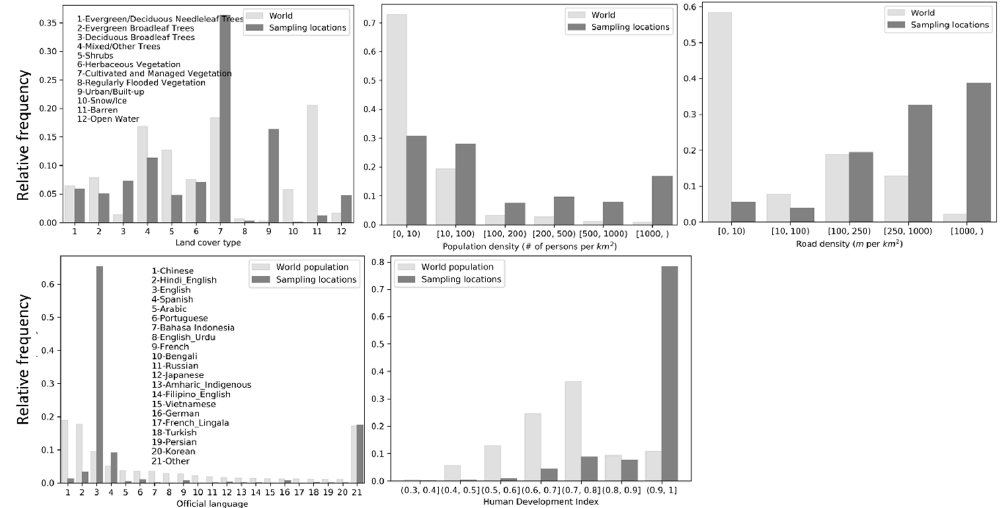
Figure 3. Frequency distribution of sampling locations and of the world on the covariates.